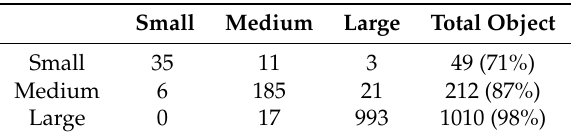
Figure 17. Results of the object using the object size. ( a ) Small size; ( b ) medium size; ( c ) large size. Table 4. Result of the classification based on the object size.